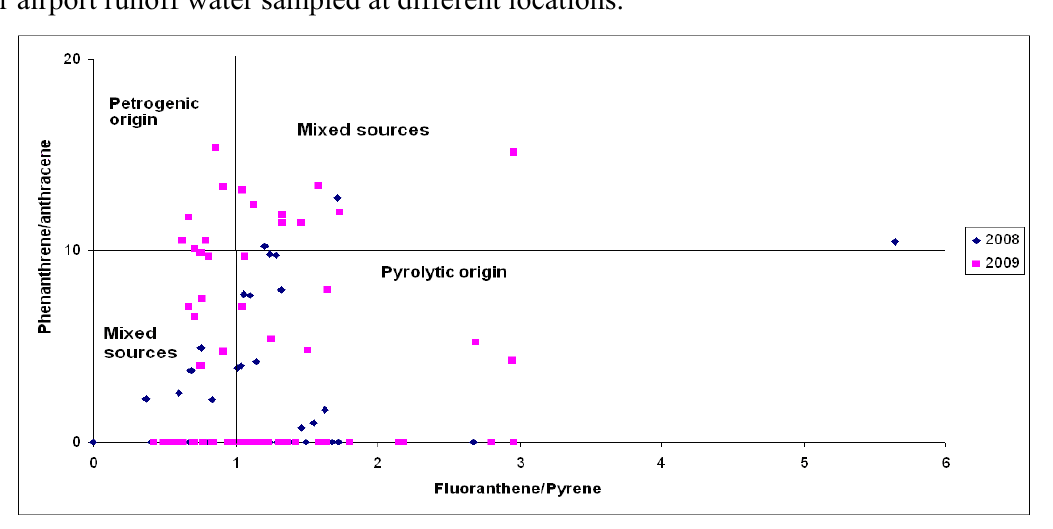
Figure 6. Cross-plot of phenanthrene/anthracene ratios against fluoranthene/pyrene ratios for airport runoff water sampled at different locations.